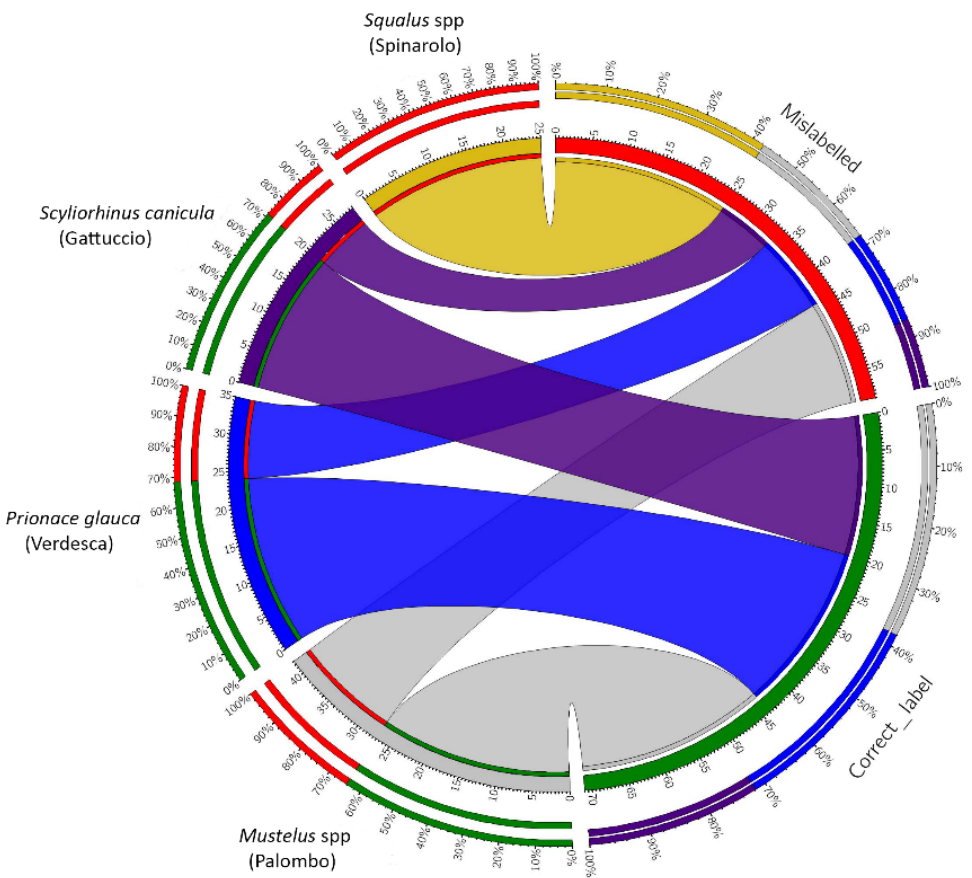
Figure 1. Circos plot summarizing correspondence between the original label of samples and the molecular identification by similarity. On the left, results are reported based on species. Bundle colors represent the four species expected from the original labels (Palombo gray; Verdesca blue; Gattuccio purple; Spinarolo gold). Within each species, the bundle is split into two parts with width corresponding to the relative abundance of samples found to be correctly labelled or mislabeled. Only in spinarolo does the presence of a whole bundle highlight the absence of correct matches. On the right, results are reported based on identifications (correct or mislabeled). The inner ring reports the total number of specimens with correct labels (green) and mislabeled (red), while the external parts show the relative abundance of each species for each condition (correct or incorrect label) using the color of the